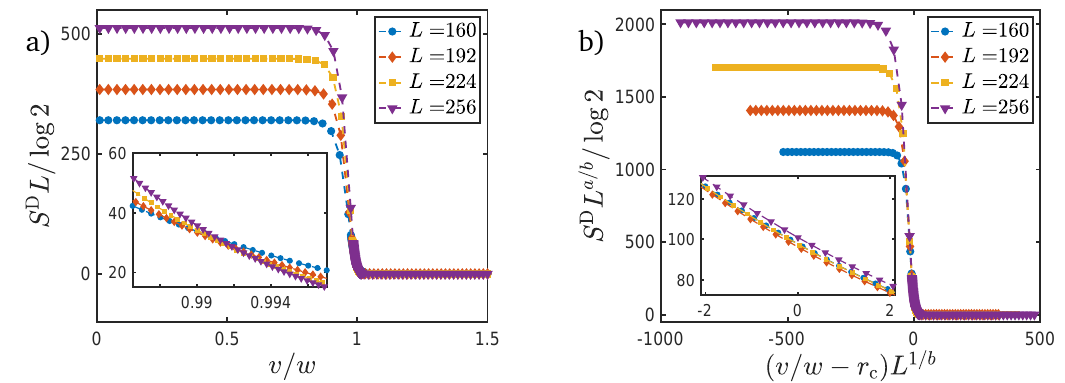
Figure 3: (Color online) a) Curve intersection of S D L as a function of the ratio v / w = L = 64. It extracts the critical point at the crossing, v / w = 0.958 here for L A B (1 theoretically). b) Best curve collapse of the Ansatz Eq. 22 obtained for a = 1.01 and b = 0.81. The clear collapse in inset signals the universal behavior of λ at the